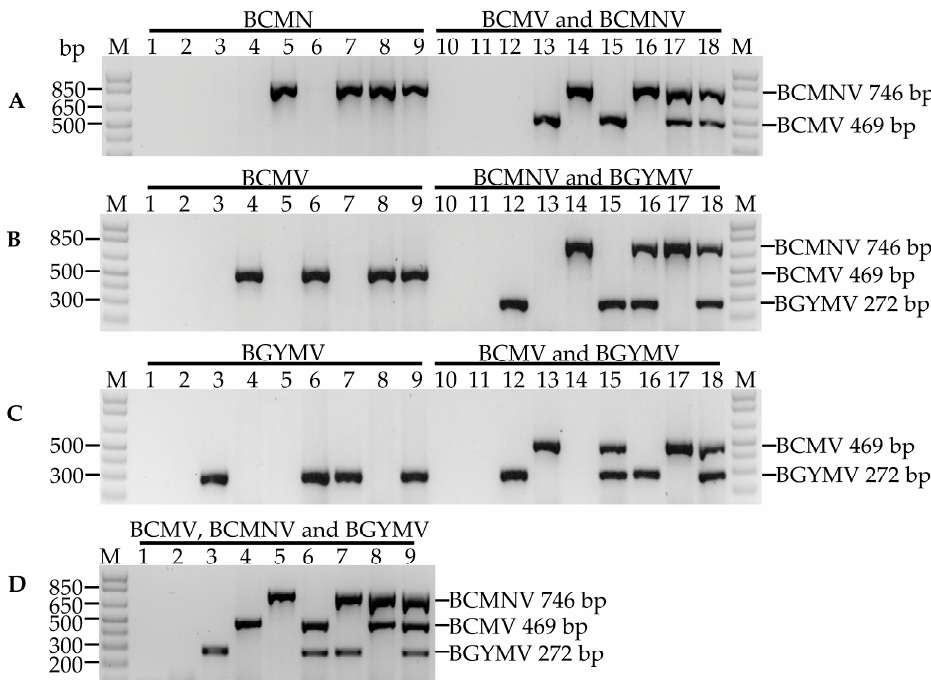
Figure 2. Determination of specificity and compatibility of primer pairs for the detection of bean common mosaic virus (BCMV), bean common mosaic necrotic virus (BCMNV) and bean golden yellow mosaic virus (BGYMV) in ( A , B , C ) uniplex, ( A , B , C ) duplex and ( D ) multiplex PCR. The combinations of the viruses detected with specific primers are shown above in each photograph. Lanes 1 and 10: non ‐ template control; lanes 2 and 11: negative control (cDNA from healthy plant); lanes 3 and 12: single BGYMV control; lanes 4 and 13: single BCMV control; lanes 5 and 14: single BCMNV control; lanes 6 and 15: double BCMV and BGYMV control; lanes 7 and 16: double BCMNV and BGYMV control; lanes 8 and 17: double BCMV and BCMNV control; lanes 9 and 18: triple BCMV, BCMNV and BGYMV control. M: Molecular marker 1 kb plus DNA ladder. The sizes of the amplified product for each virus are shown at the right of the